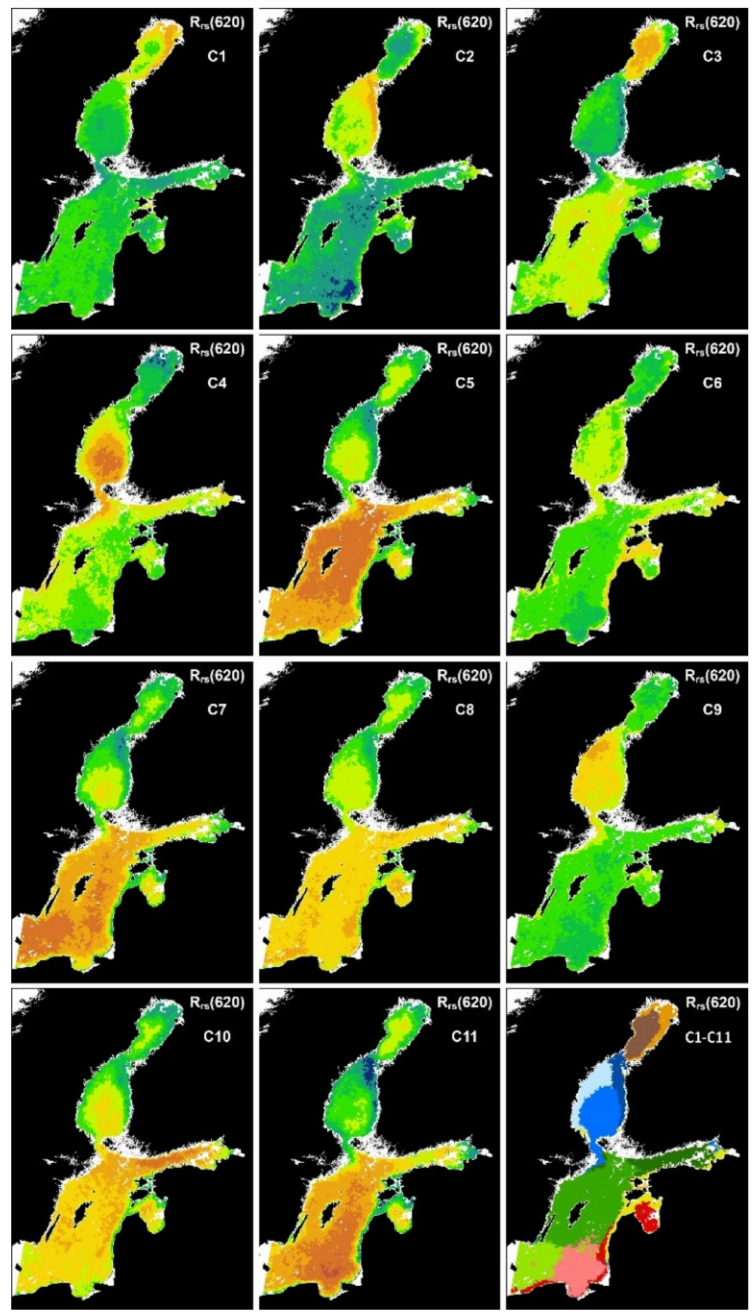
Figure 9. Areas of distinctive R rs (620) dynamics Cn where n = 1 to 11 based on R z (620) and the binwise time series DTW distances from the prototypes of the clusters. The color coding of the DTW distances in C1 to C11 is the same as in Figure 7. The clustering result is given in the image “C1–C11” with a specific color for each